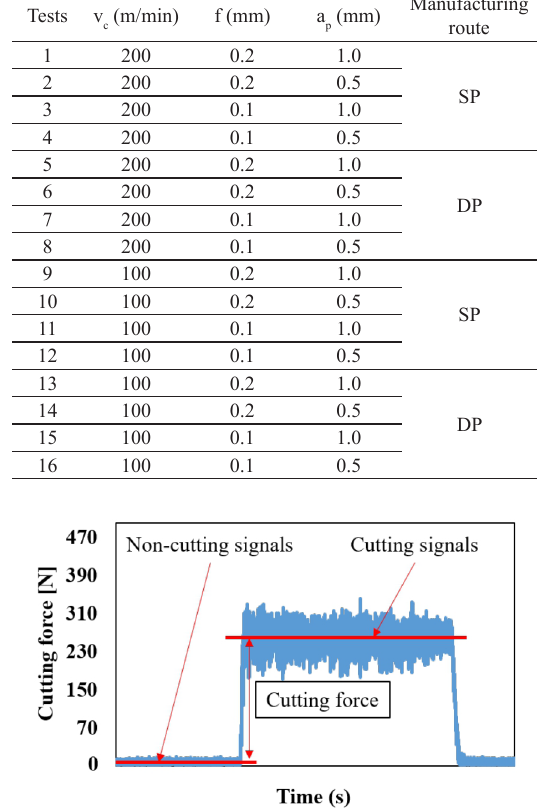
Figure 3. Measurement of forces with relative